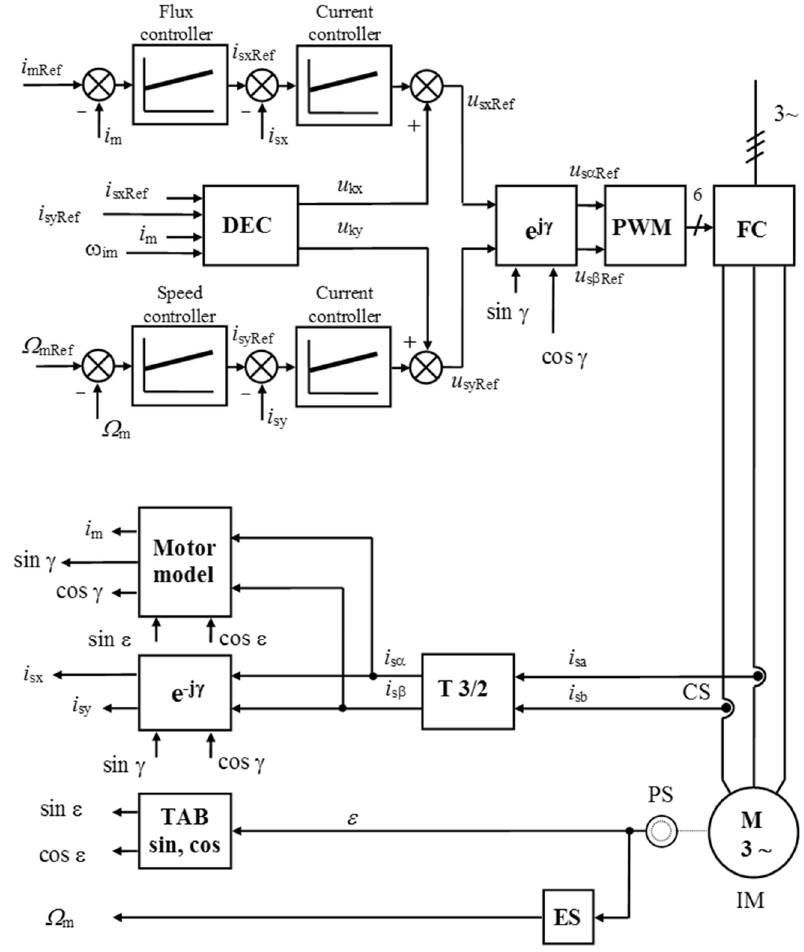
Figure 3. Vector-controlled induction motor